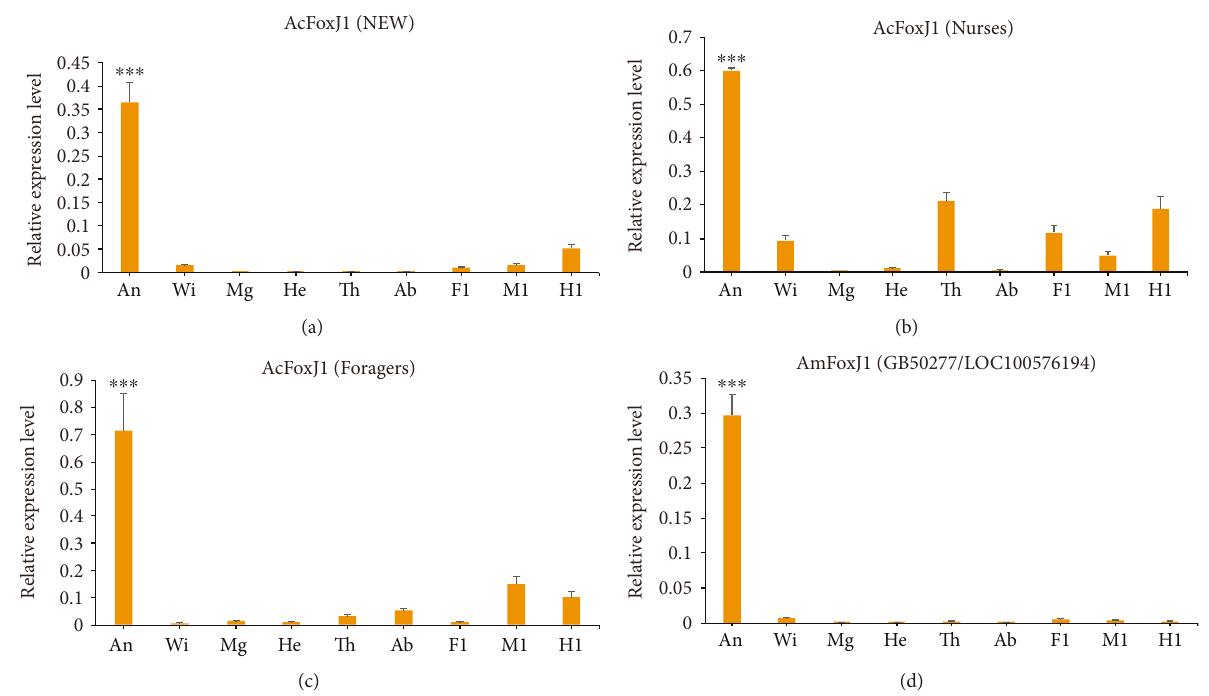
Figure 6: Expression patterns of FoxJ1 in A. cerana and A. mellifera . (a, b, and c) The tissue expression pro fi les of A. cerana FoxJ1 from newly emerged workers (NEW), nurses, and foragers, respectively. (d) The tissue expression pro fi les of FoxJ1 in adult A. mellifera . ∗∗∗ p < 0 001